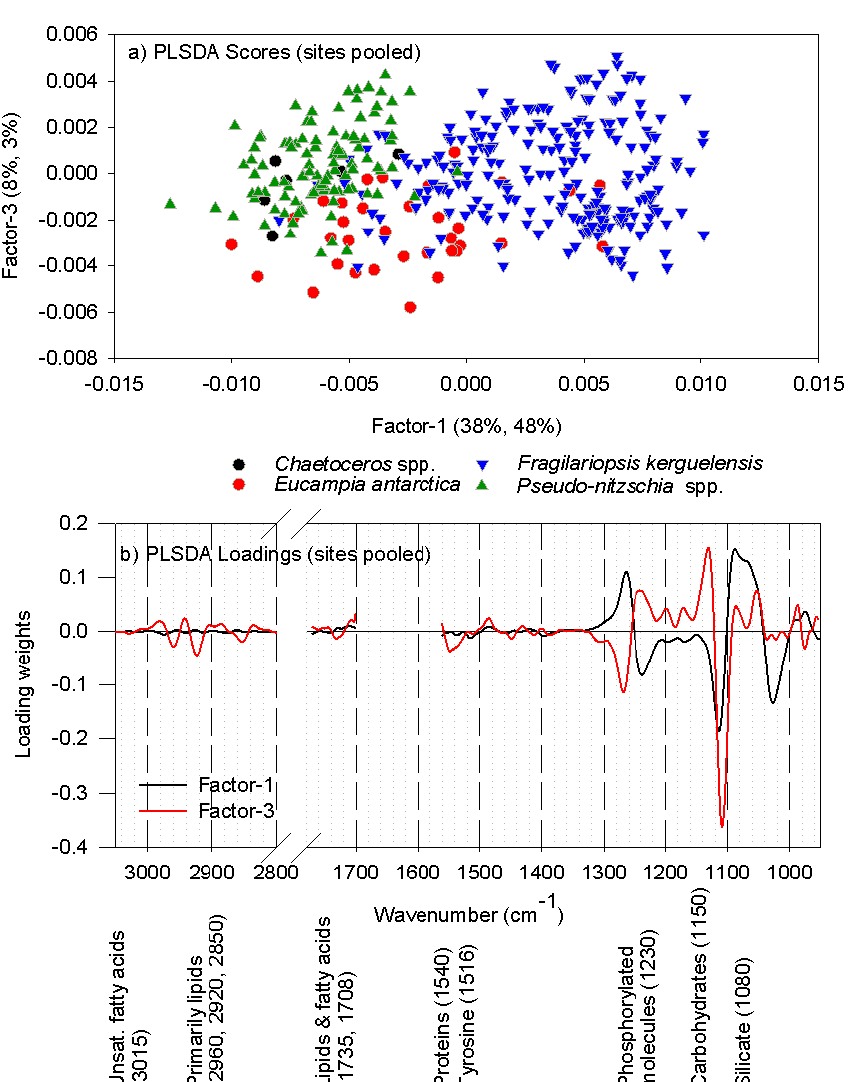
Figure 4. Classification of cell spectra by PLSDA with data pooled across stations. PLSDA score plot (a) shows clustering of cell spectra by taxon. PLSDA loading-weights plot (b) shows spectral bands which drive variation between cell spectra – primarily phosphorylated molecules (1230cm − 1 ) , carbohydrates (1150cm − 1 ) and silicate/silicic acid (1080cm − 1 )